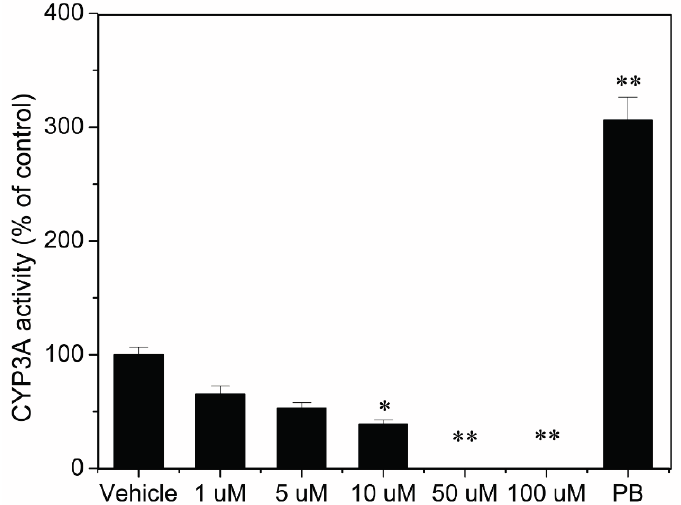
Figure 5. Induction of CYP3A activity in rat hepatocytes by TCAS. Values are presented as M ± SD (n = 3 rats). * p < 0.05 and ** p < 0.01 indicate statistically significant